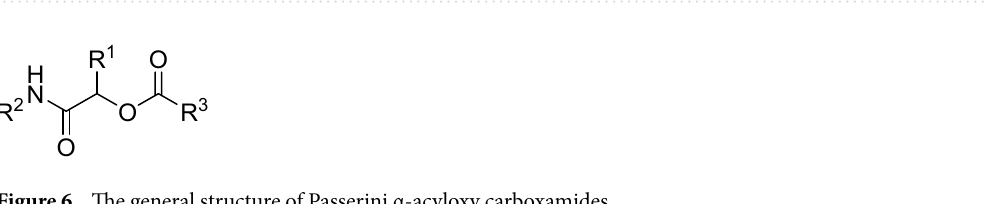
Figure 5. Synthesis of 9 and 11 via Passerini reaction using trihaloacetic acids.